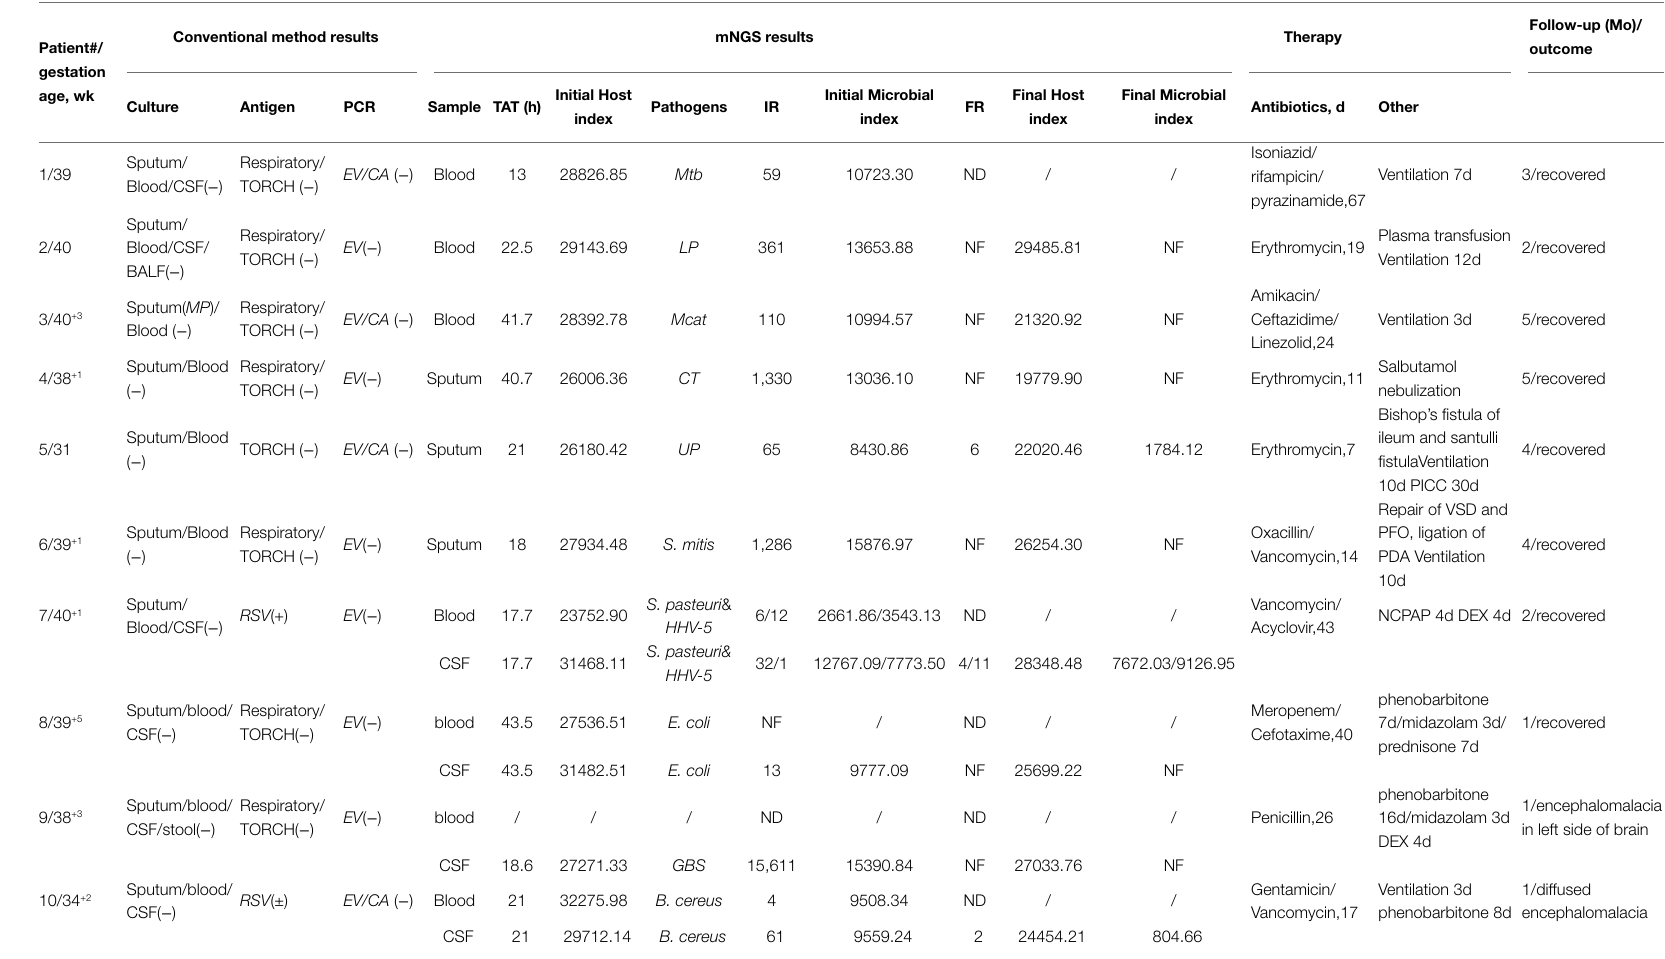
TABLE 2 | mNGS findings of the 10